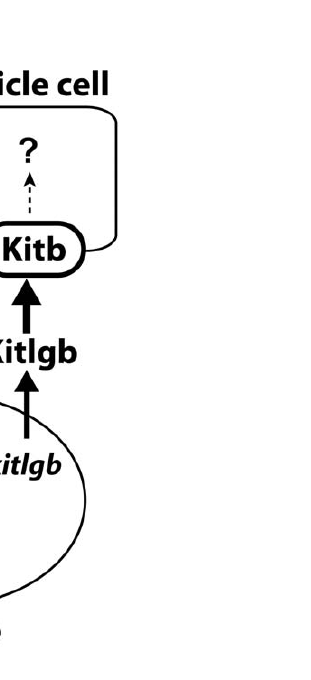
Figure 14. The hypothetical model for the existence of a Kit- mediated bi-directional communication network in the zebra- fish ovarian follicle. The follicle cell-derived Kitlga specifically targets its receptor Kita on the oocyte with a minor action on Kitb on the follicle cells as well, similar to the KITL-KIT system in mammals. The Kitlgb, however, is exclusively expressed in the oocyte and it acts on its specific receptor Kitb on the follicle cells, representing a potential paracrine signaling pathway for the oocyte to control the follicle cells. The expression of Kitlga in the follicle cells is likely subject to regulation by various endocrine and/or paracrine factors, therefore mediating the actions of these factors on the oocyte.